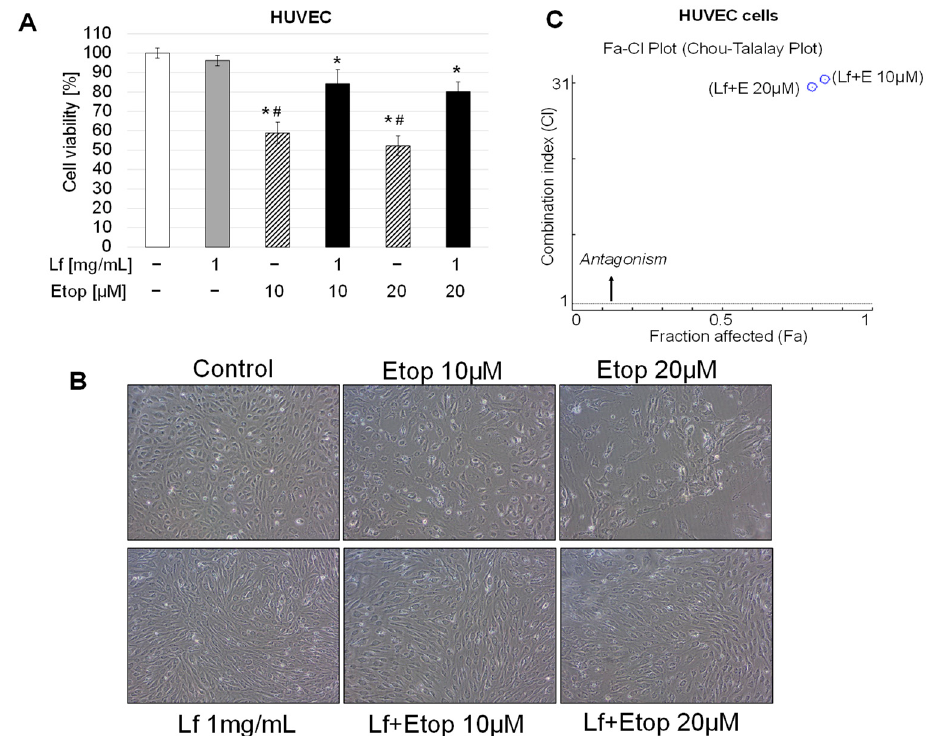
Figure 7. Effect of rhLf on etoposide-induced cytotoxicity of human endothelial cells. ( A ) Confluent HUVEC cells were cultured in the presence of rhLf (Lf) and etoposide (Etop) alone or the combination at indicated concentrations. Cell viability was quantified by a WST-1 assay after 72 h. The data are expressed as the mean ± SD of three experiments performed in duplicate. ( B ) Visualization of the effect of etoposide alone and in combination with rhLf on confluent, cell morphology, and density of HUVEC cells. Representative phase-contrast cell images are shown after 72 h treatment (100 × magnification). ( C ) Analysis of the type of interaction between rhLf and etoposide in HUVEC cells by the CompuSyn software. Fa-CI plot (Chou-Talalay Plot) showing the antagonistic effect of combination rhLf and etoposide (Lf + E) for each fraction affected. CI < 1 indicates synergism; CI = 1 indicates additivity; CI > 1 indicates antagonism. * p < 0.05 compared to the control and # p < 0.05 compared to the combination treatment at the same concentration of etoposide.